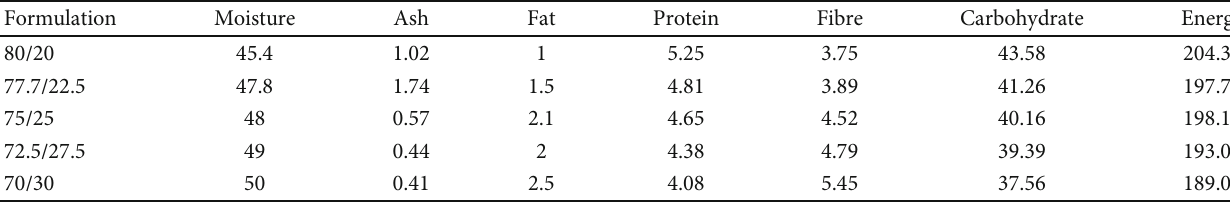
Table 2: Proximate analysis outcome of the raw cereal blends (g/100 g).